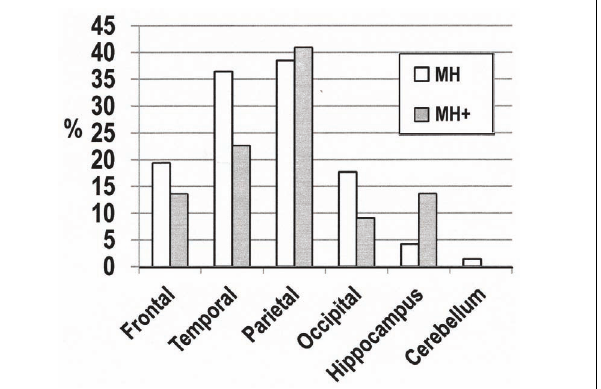
FIGURE 1 | Number of brain regions with microscopic hemorrhage (MH) or MH + (lesion with > 5 siderophages) and of brain regions with concomitant cerebral amyloid angiopathy (CAA) and MH (MHCAA, MH + CAA). the whole study population (1.0%, Tanskanen et al., 2012). Sim-